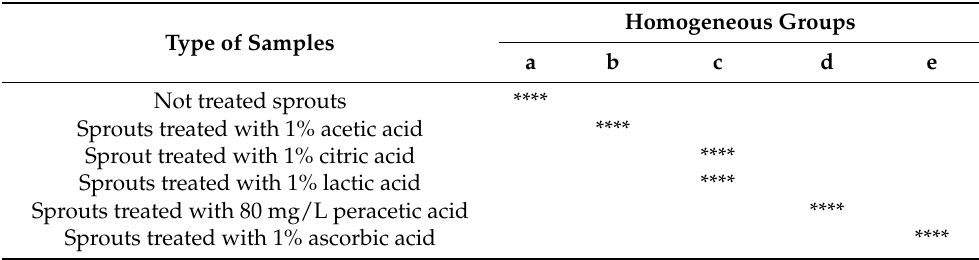
Table 3. Group homogeneity test ( α = 0.05) comparing the effect of applied organic acids on the content of polyphenols (TPC) in red cabbage sprouts subjected to 14-day storage.